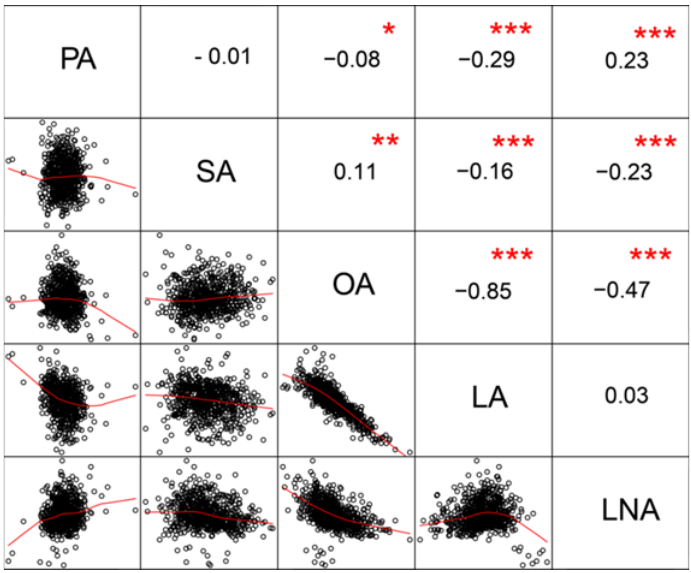
Figure 3. Pearson’s correlation coefficients between soybean seed fatty acid composition. * Significant at the P < 0.05 probability level, ** significant at the P < 0.01 probability level, *** significant at the P < 0.001 probability level. Values without asterisks are not significant at P < 0.05. PA, palmitic acid; SA, stearic acid; OA, oleic acid; LA, linoleic acid; LNA, linolenic acid.